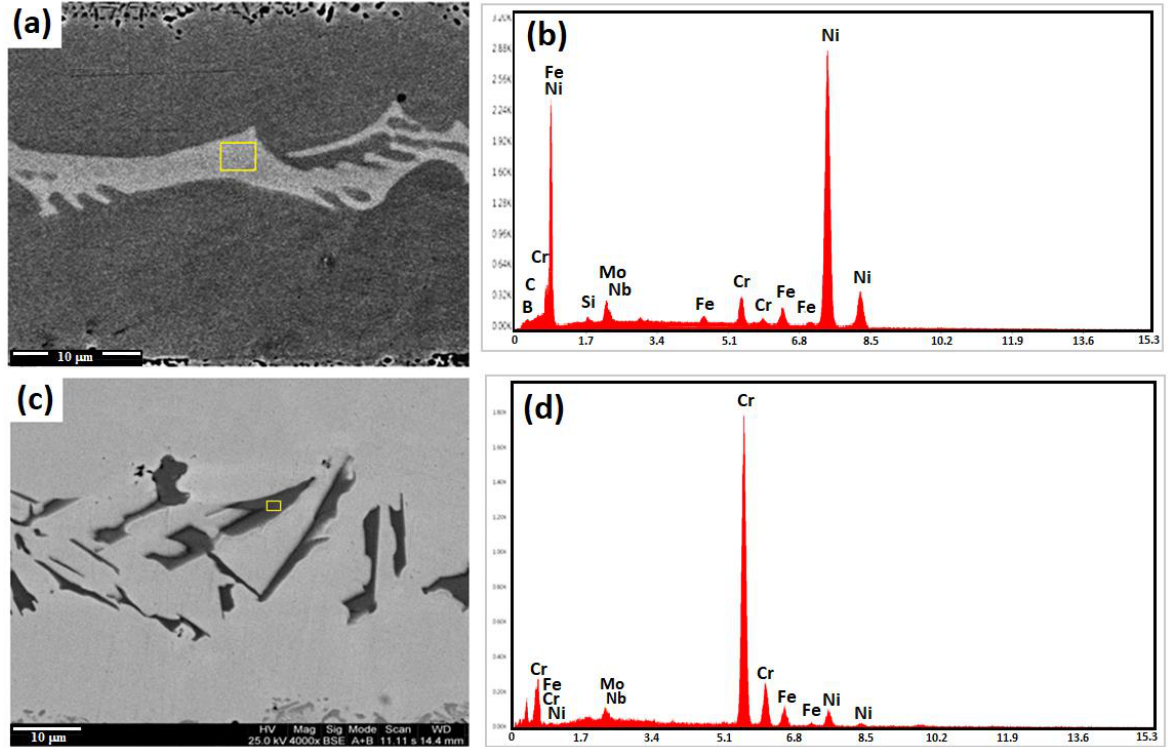
Figure 9. ( a ) The SEM micrograph and ( b ) EDS spectrum of nickel-rich boride in centerline joint of the TLP-bonded sample at 1050 °C/60 min condition; ( c ) the SEM micrograph and ( d ) EDS spectrum of chromium-rich boride in the centerline joint of the TLP-bonded sample at 1050 °C /15 min condition. Table 5. EDX analysis of various phases indicated in Figures 9 (wt.%).